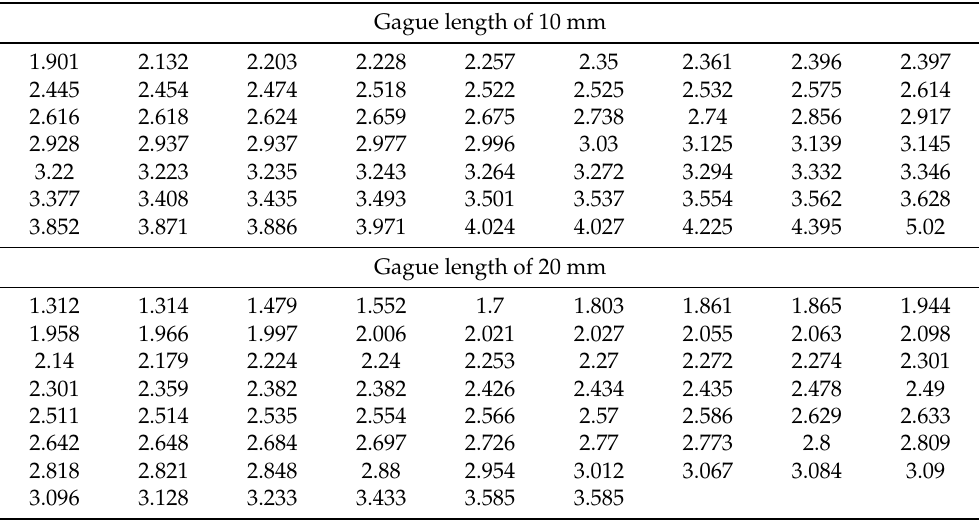
Table 4. The strength measurements of carbon fibers.